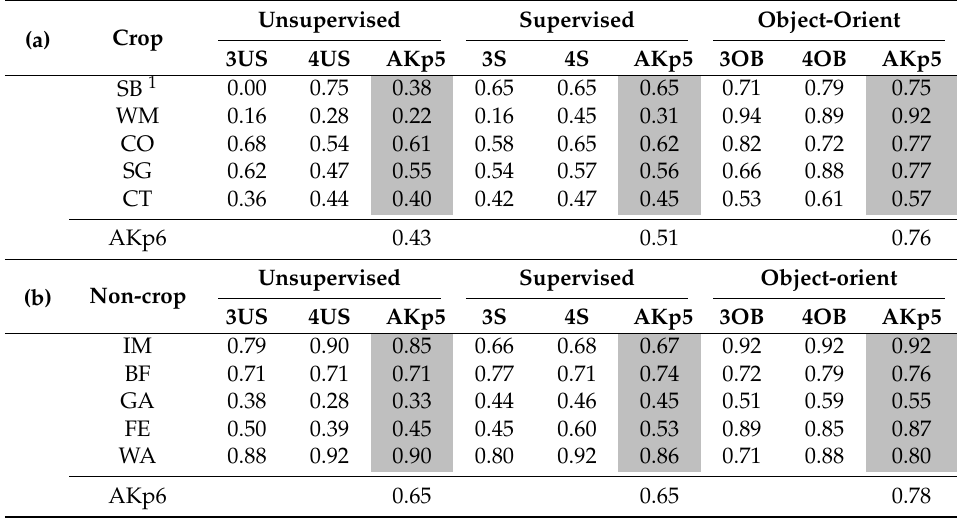
Table 6. Kappa analysis results arranged by classification method for ( a ) Crop and ( b ) Non-crop. Unsupervised Supervised Object-Orient